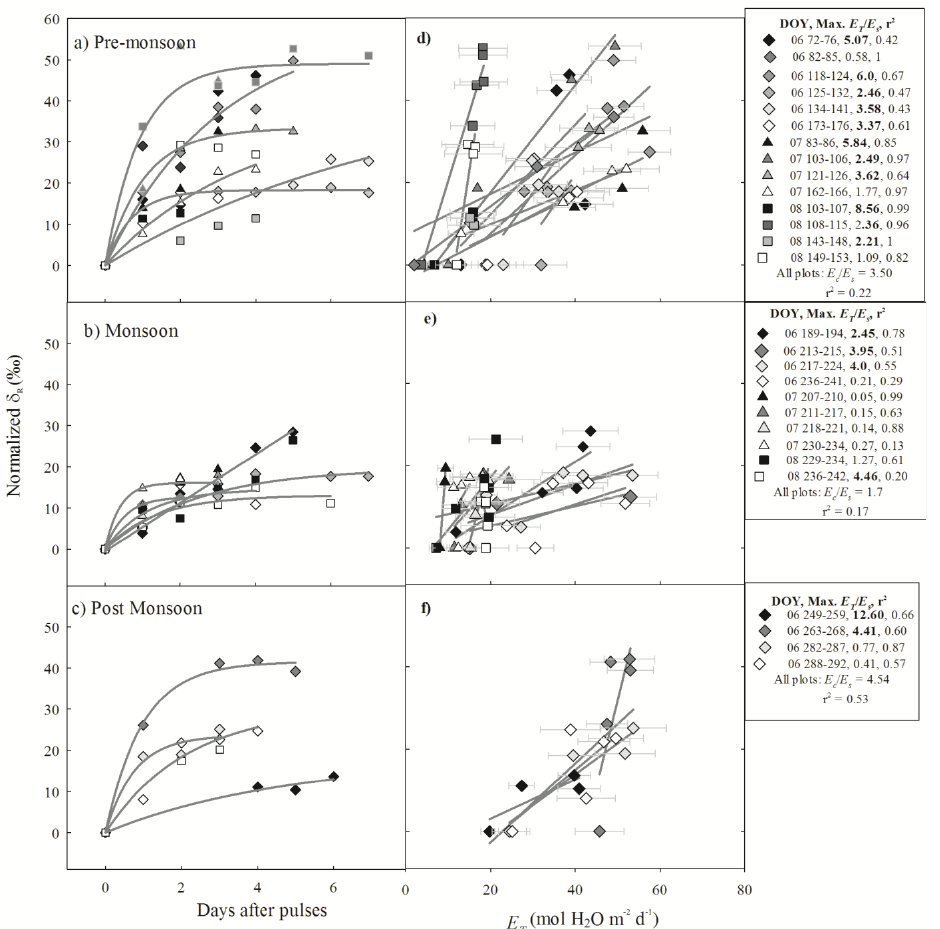
Fig. 5. (a–c) Seasonal patterns of normalized δ R enrichment after rain pulses (the pulses are on day zero). δ R values were normalized by δ R on the day of the rain event to make all starting values zero over the four years. (d–f) The seasonal relationships between post-rain-pulse normalized δ R and E T . Maximum E T / E S values and r 2 values for the same period are added in each legend. Maximum E T / E S > 2 is expressed as